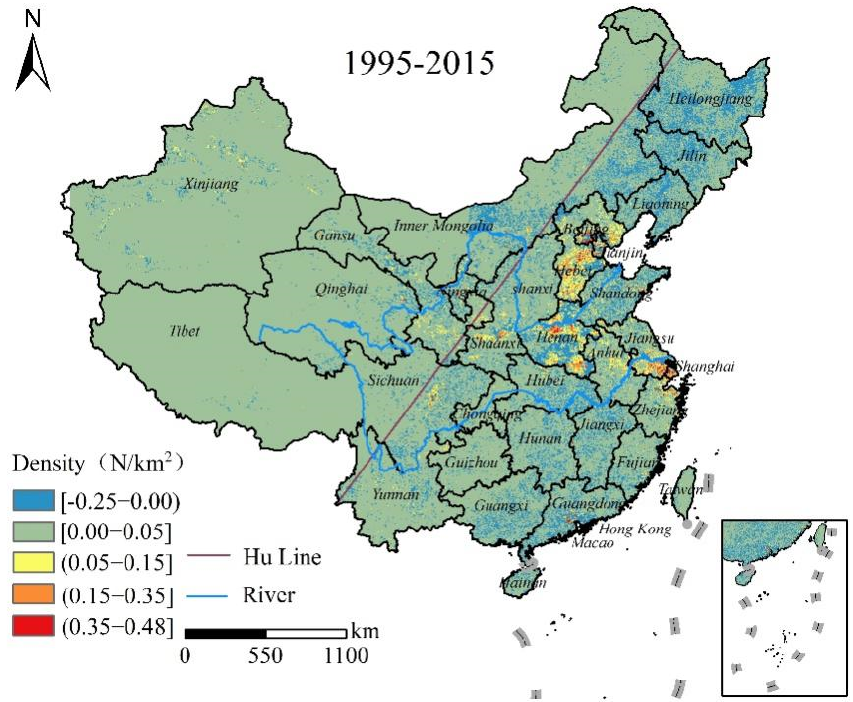
Figure 5. Changing rural settlement kernel density in China 1995–2015.